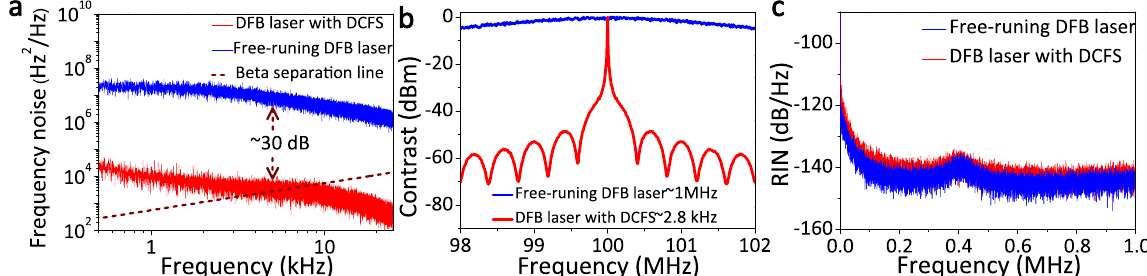
Figure 6. ( a ) Frequency-noise power spectral density of free-running DFB laser (blue line) and DFB laser with DCFS (red line), and the β -separation line given by 8ln(2)f/ π 2. ( b ) Normalized power spectrum of free-running DFB laser (blue line) and DFB laser with DCFS (red line). ( c ) Relative intensity noise (RIN) of free-running DFB laser (blue line) and DFB laser with DCFS (red